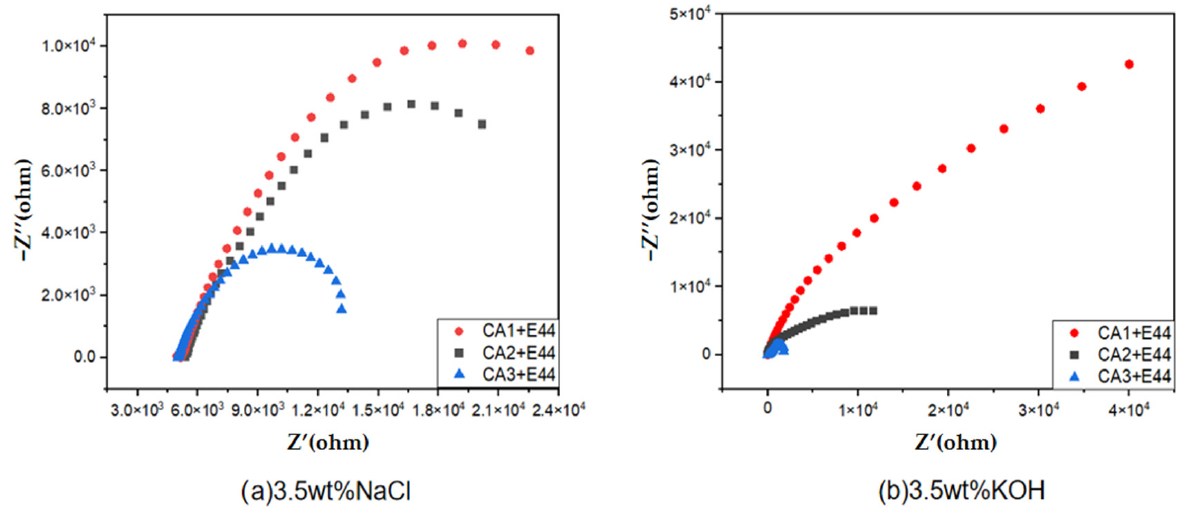
Figure 11. Nyquist curves of different coatings in 3.5 wt% NaCl ( a ) and 3.5 wt% KOH ( b ).